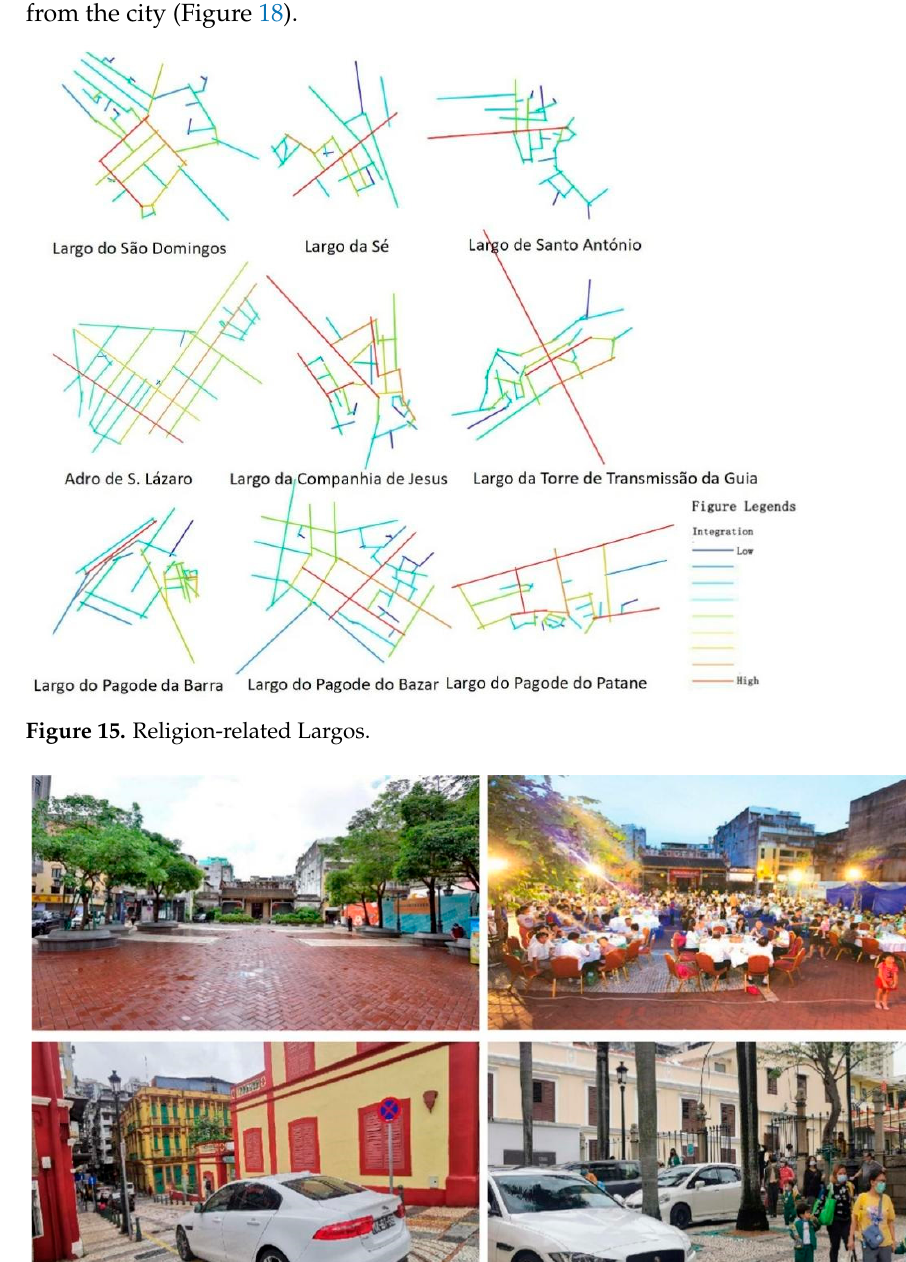
Figure 17. Largo do São Domingos, Largo do Pagode da Barra. Table 3. Syntax parameters of religion-related Largos. Name of Largo